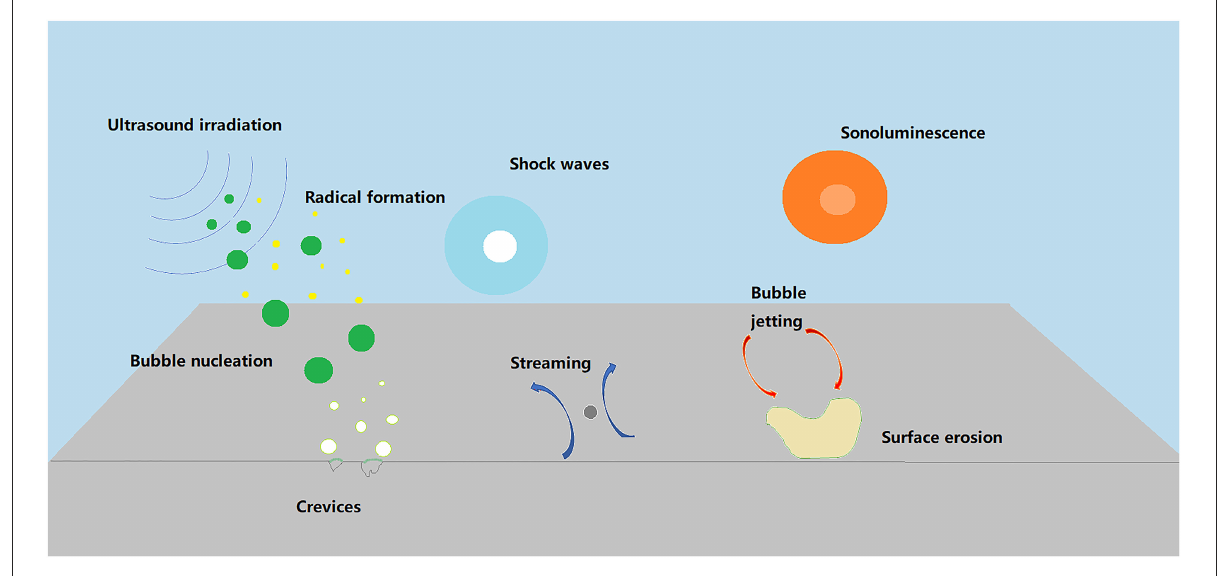
FIGURE2 Diagrammatic sketch of the impact of ultrasound on meat (Alarcon-Rojo et al.,